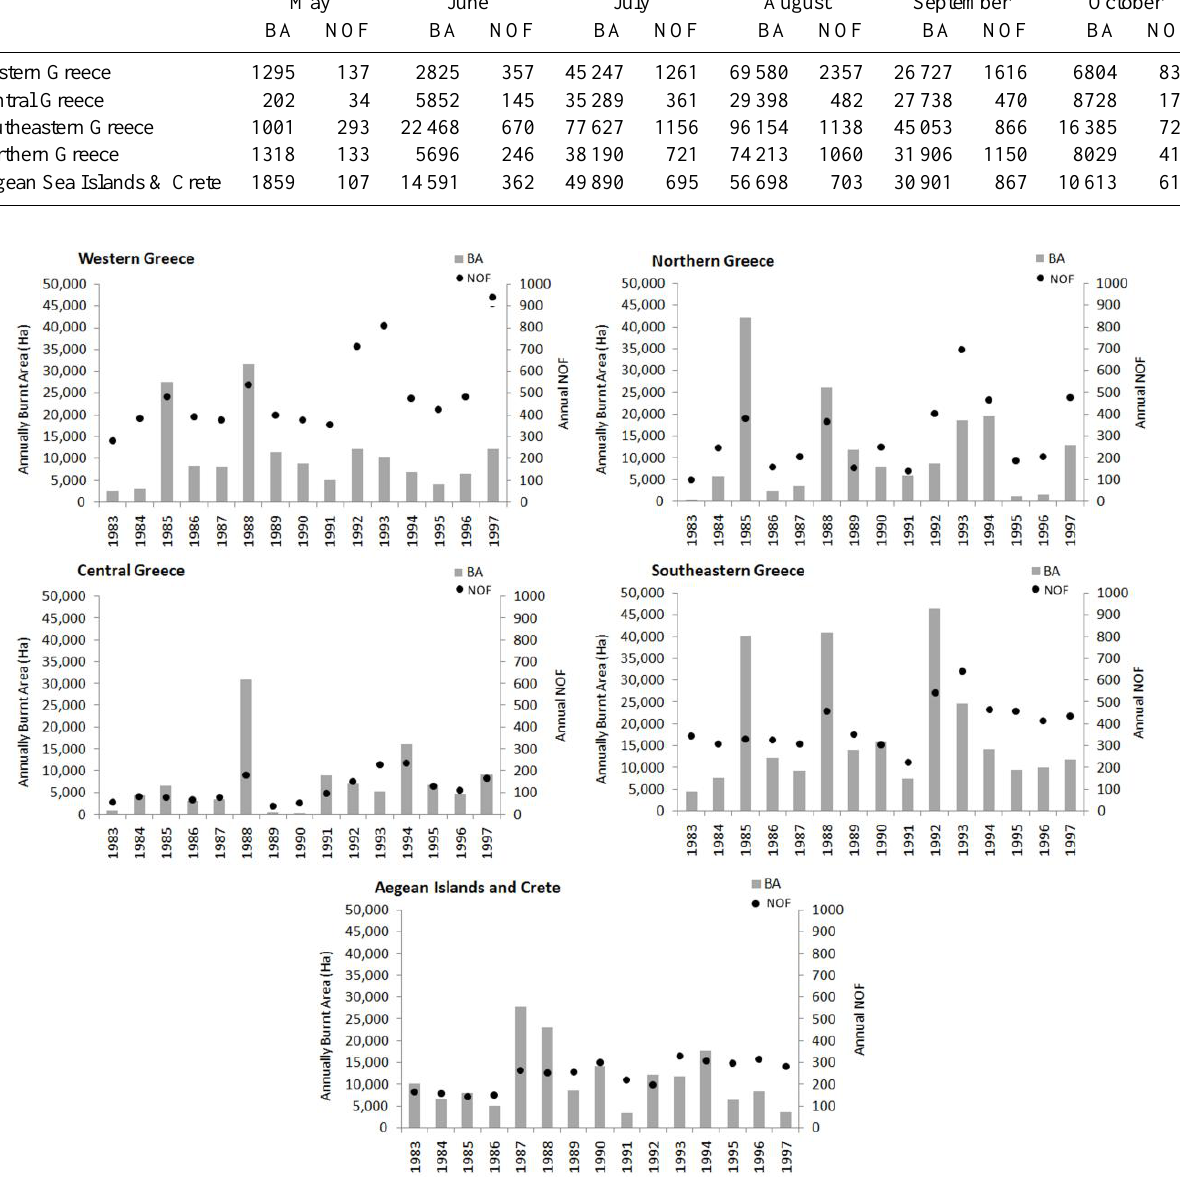
Fig. 2. Annually burnt area and number of fire events for the five sub-regions of the Greek domain for the 1983-1997 period. 3